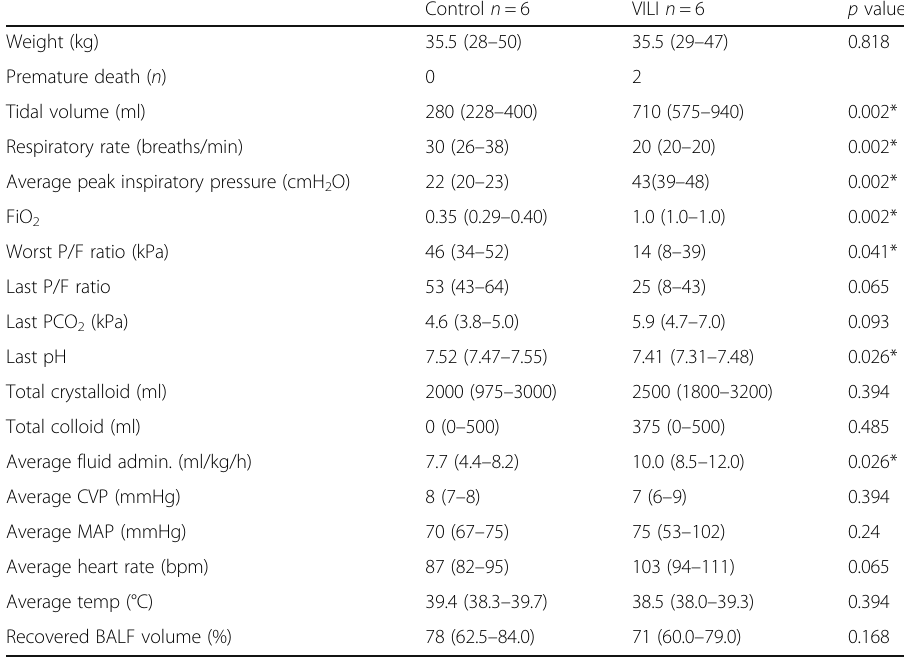
Table 1 Characteristics of the pigs by study group. Data are presented as the median (interquartile